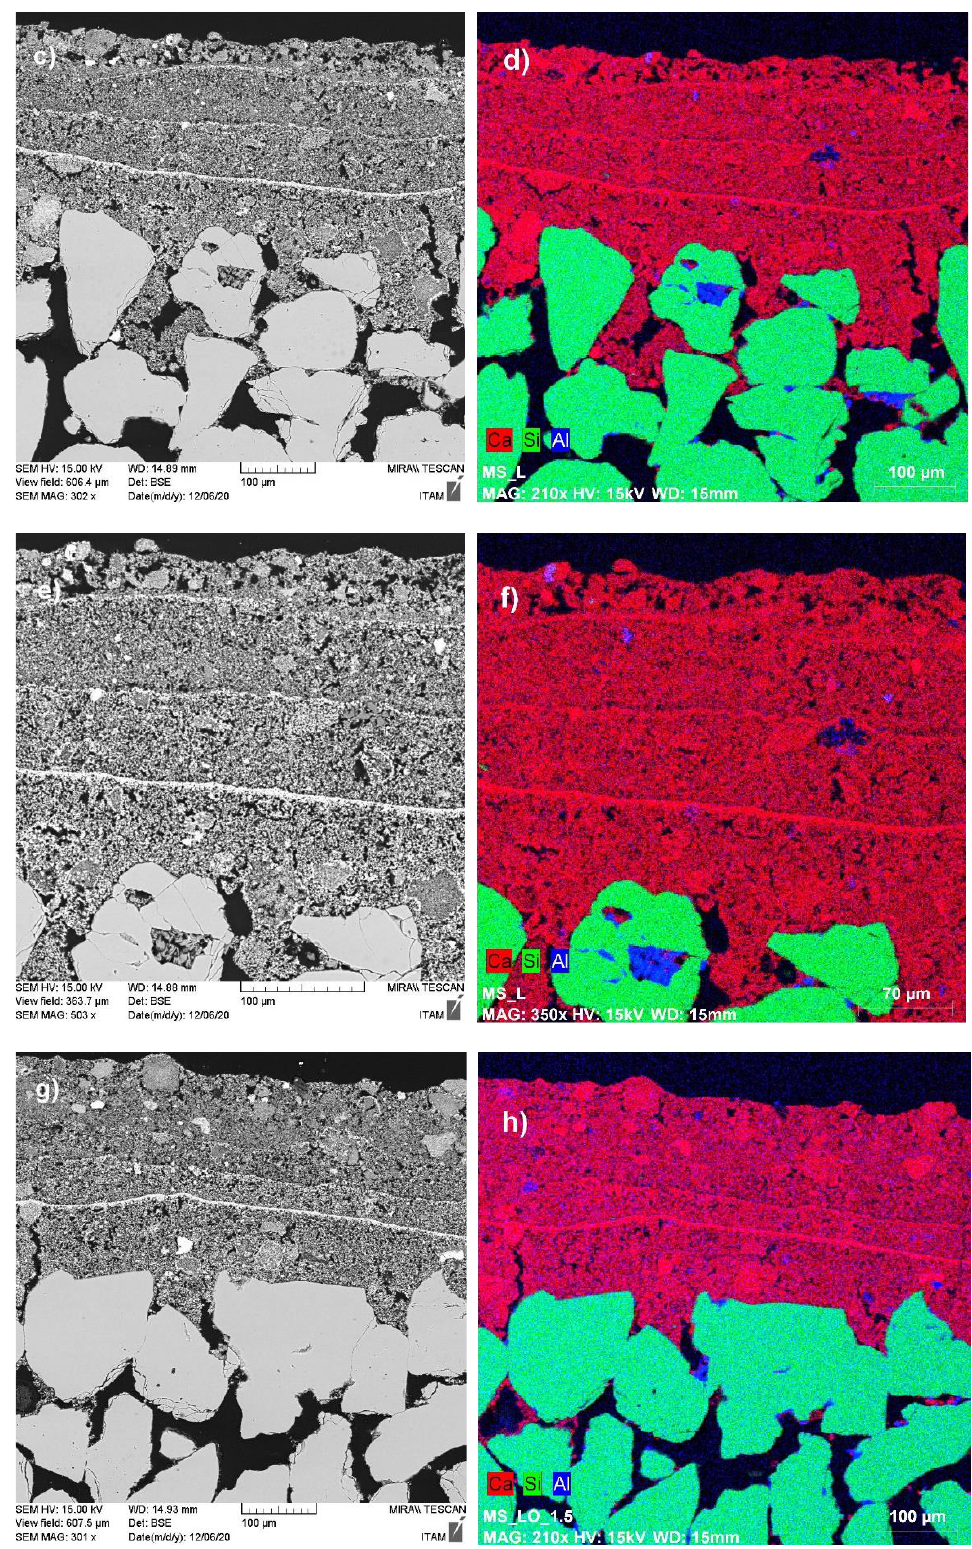
Figure 8. SEM photomicrographs of Mšené and respective EDX elemental maps : ( a ) SEM image of MS/R; ( b ) SEM-EDX map of MS/R; ( c ) SEM image of MS/L; ( d ) SEM-EDX map of MS/L; ( e ) SEM image of MS/L showing a detail of the paint layers; ( f ) SEM-EDX image of MS/L showing a detail of the paint layers; ( g ) SEM image of MS/LO/1.5; ( h ) SEM-EDX map of MS/LO/1.5.